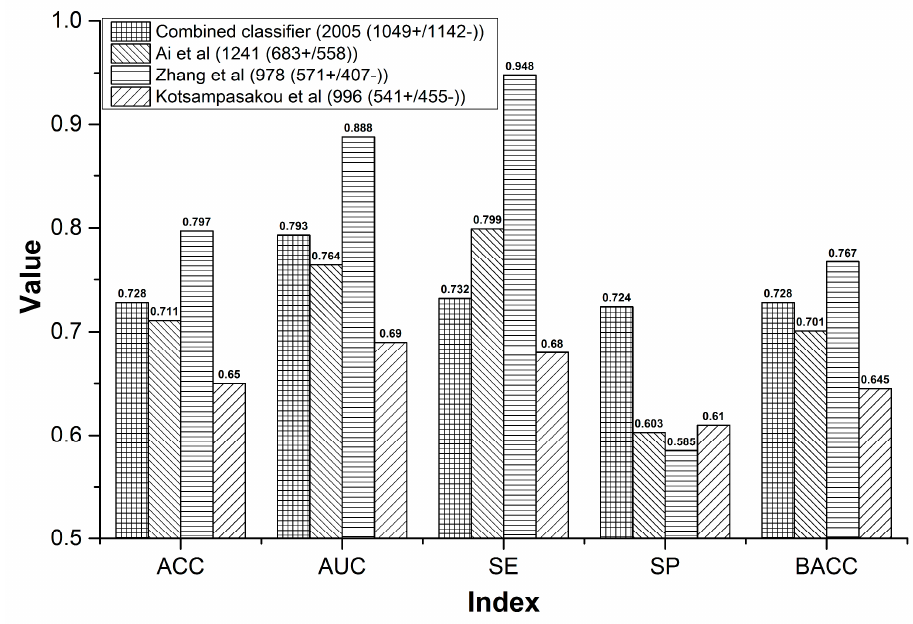
Figure 3. Comparisons between the combined classifier and prior studies within cross validation.